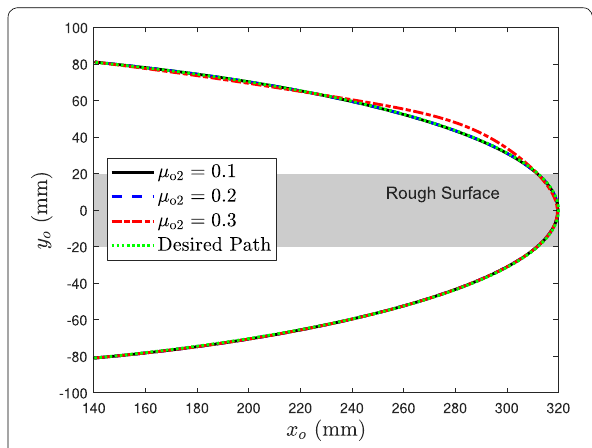
Fig. 18 Comparison of the object path and desired